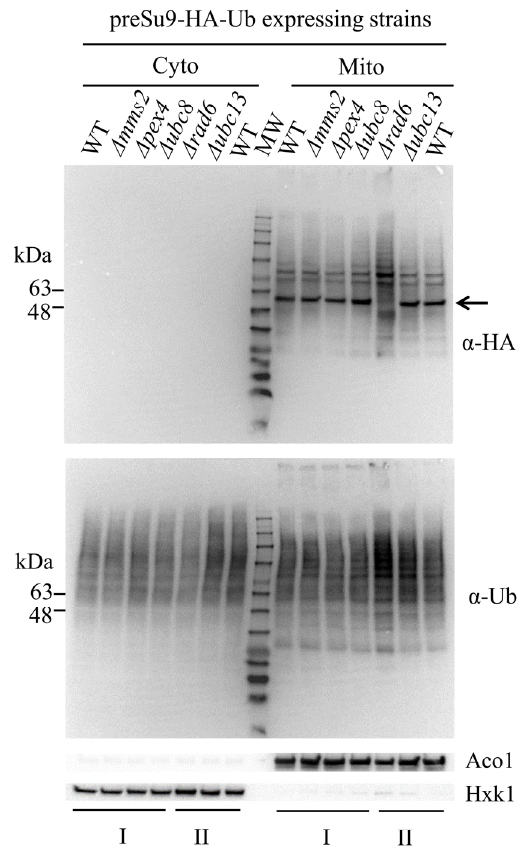
Figure 5. RAD6 deficiency causes an altered mitochondrial ubiquitination pattern. Effect of single E2 KO on the mitochondrial ubiquitination pattern. Wild-type (WT) or single E2 KO cells expressing preSu9-HA-Ub were subjected to subcellular fractionation. Cytosolic (Cyto) and mitochondrial (Mito) subcellular fractions were probed for HA or ubiquitin (Ub) by WB. Aco1 and Hxk1, respectively, are mitochondrial and cytosolic markers. The line arrow indicates the migration position of the major band between 48 and 63 kDa. Samples prepared from two batches of subcellular fractionation are indicated with I and